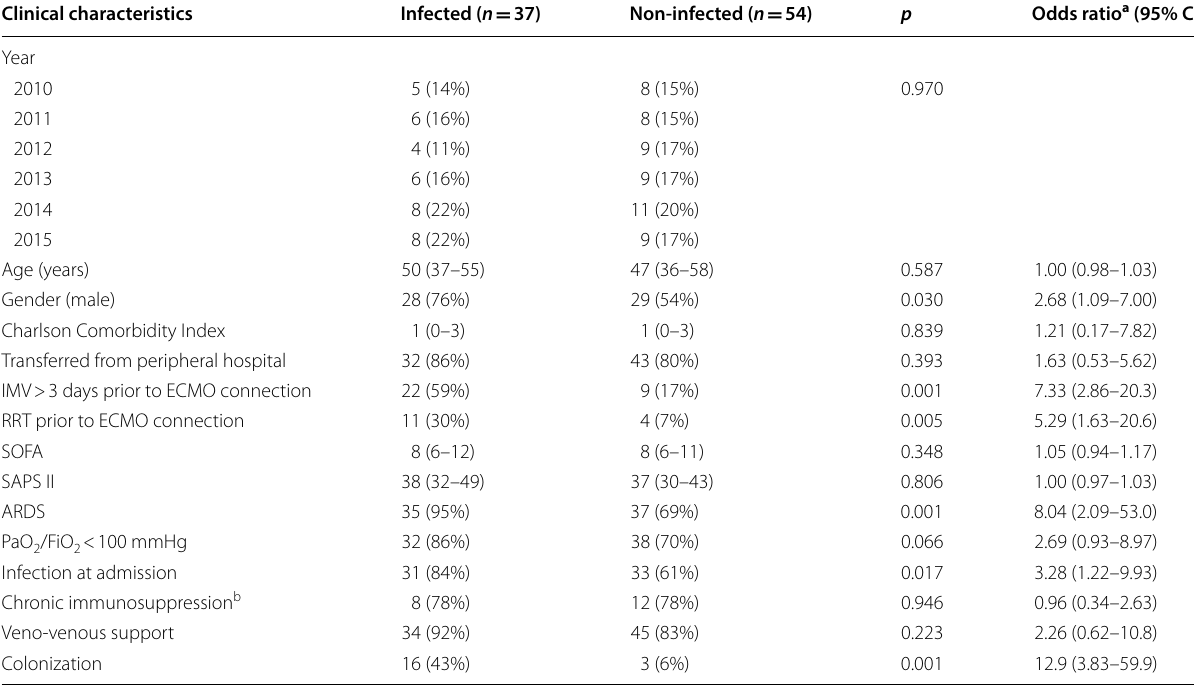
Table 3 Univariable logistic regression analyzing risk factor for infection due to multidrug-resistant Gram-negative bacteria Clinical